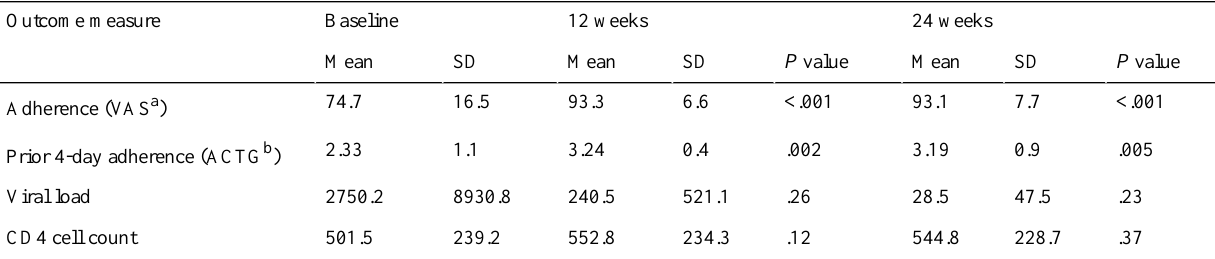
Table 2. Baseline and follow-up adherence and biomarker outcomes (n = 21 of